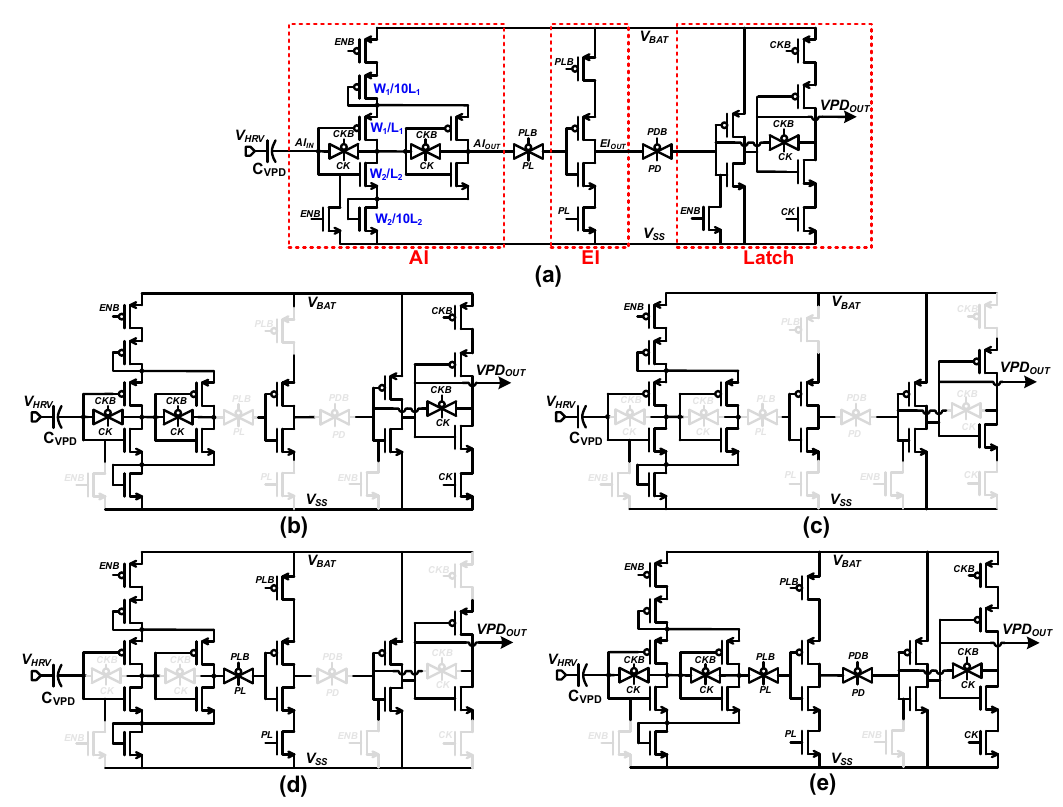
Figure 8. Proposed voltage peak detector (VPD): ( a ) Circuit, ( b ) Reset phase, ( c ) Amplification phase,. ( d ) Evaluation phase, and ( e ) Latch update phase.